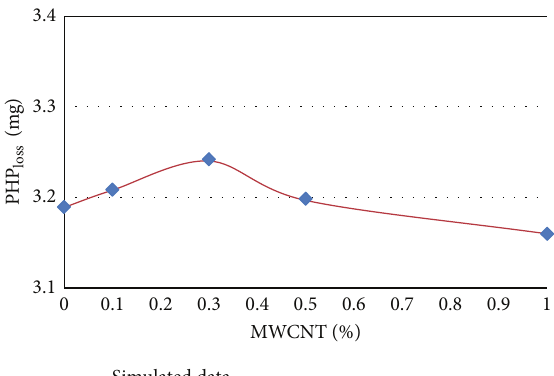
Figure 8: Experimental and simulated values of PHP loss for 56 days by artificial neural networks.